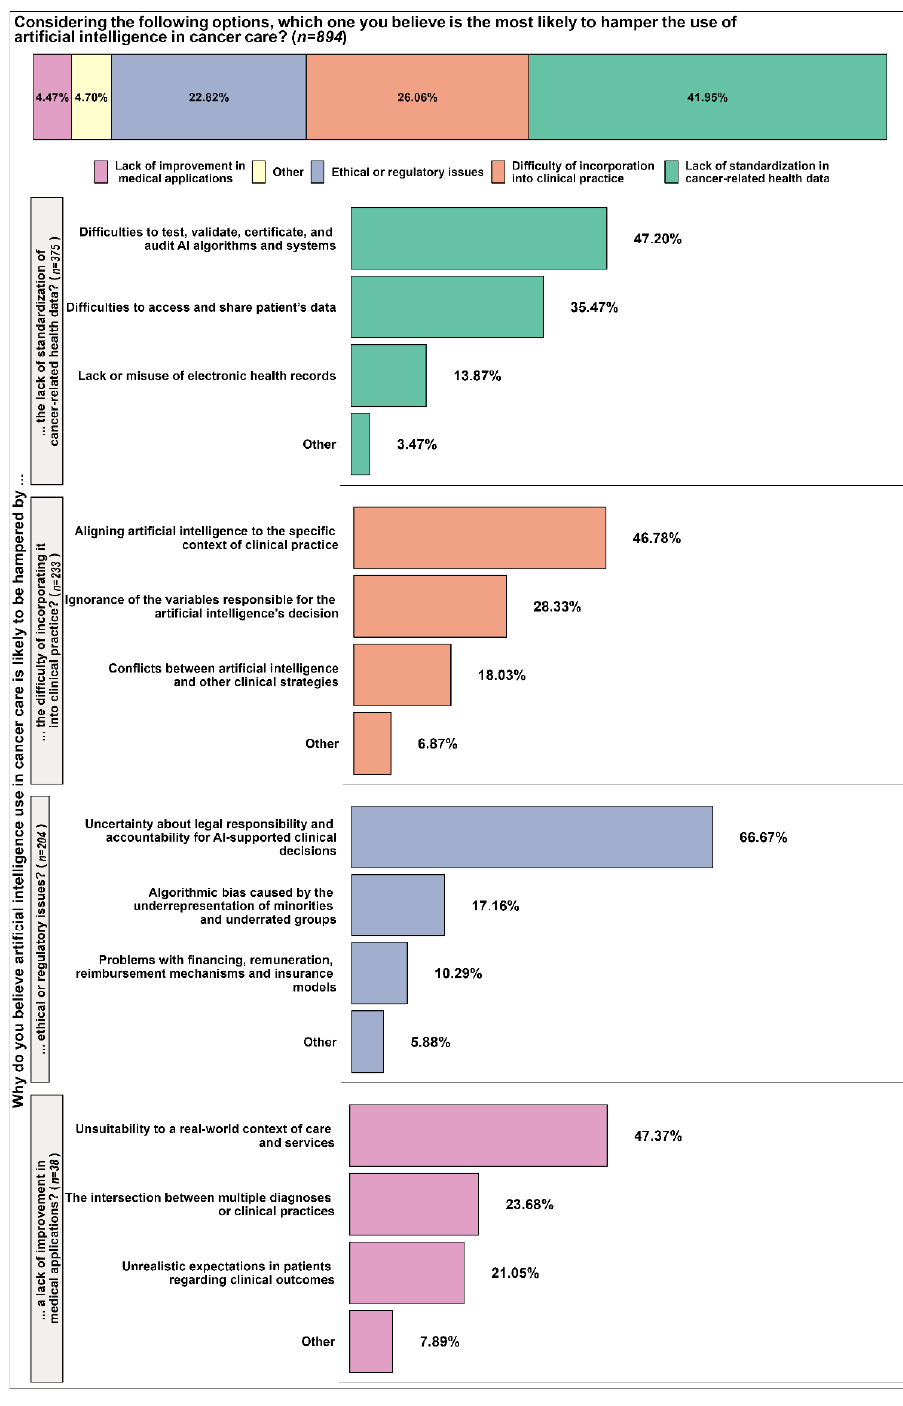
Figure 5. Barriers to the use of AI in cancer